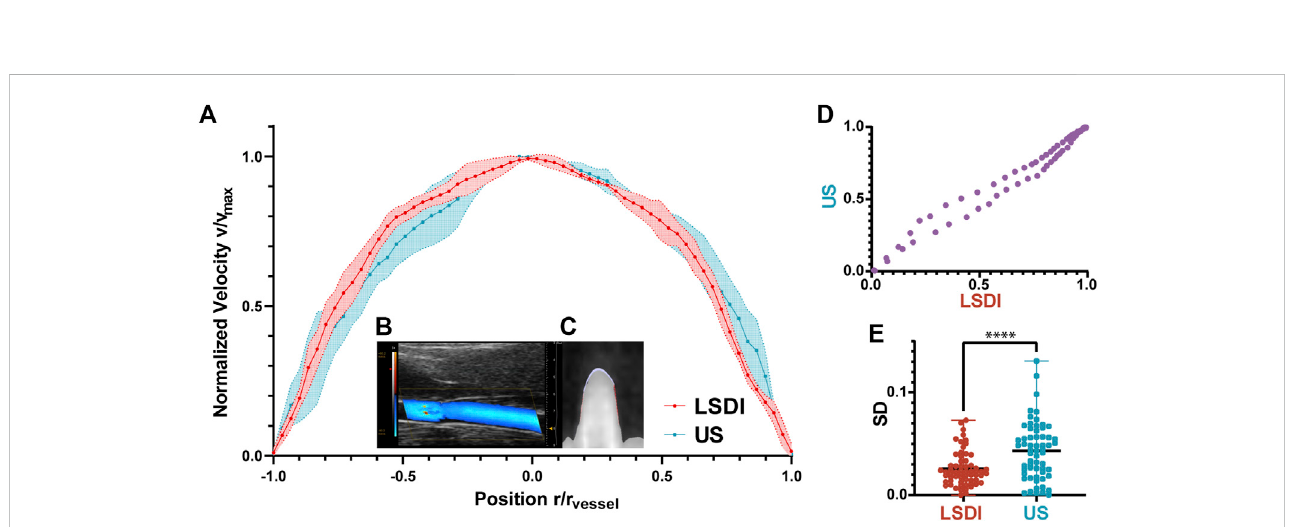
FIGURE 4 Normalized blood fl ow velocity pro fi les measured by LSDI and ultrasonic (A) . Ultrasonic imaging of blood fl ow in CCA scanned by color Doppler fl ow imaging mode (B) . LSDI imaging of blood fl ow in CCA (C) . The correlation between the two groups of datapoints measured by LSDI and US (D) . The velocity pro fi les obtained by the two methods are consistent (Spearman r = 0.990, p < 0.0001). Standard deviation distribution of datapoints in the two methods (E) , ****: p <